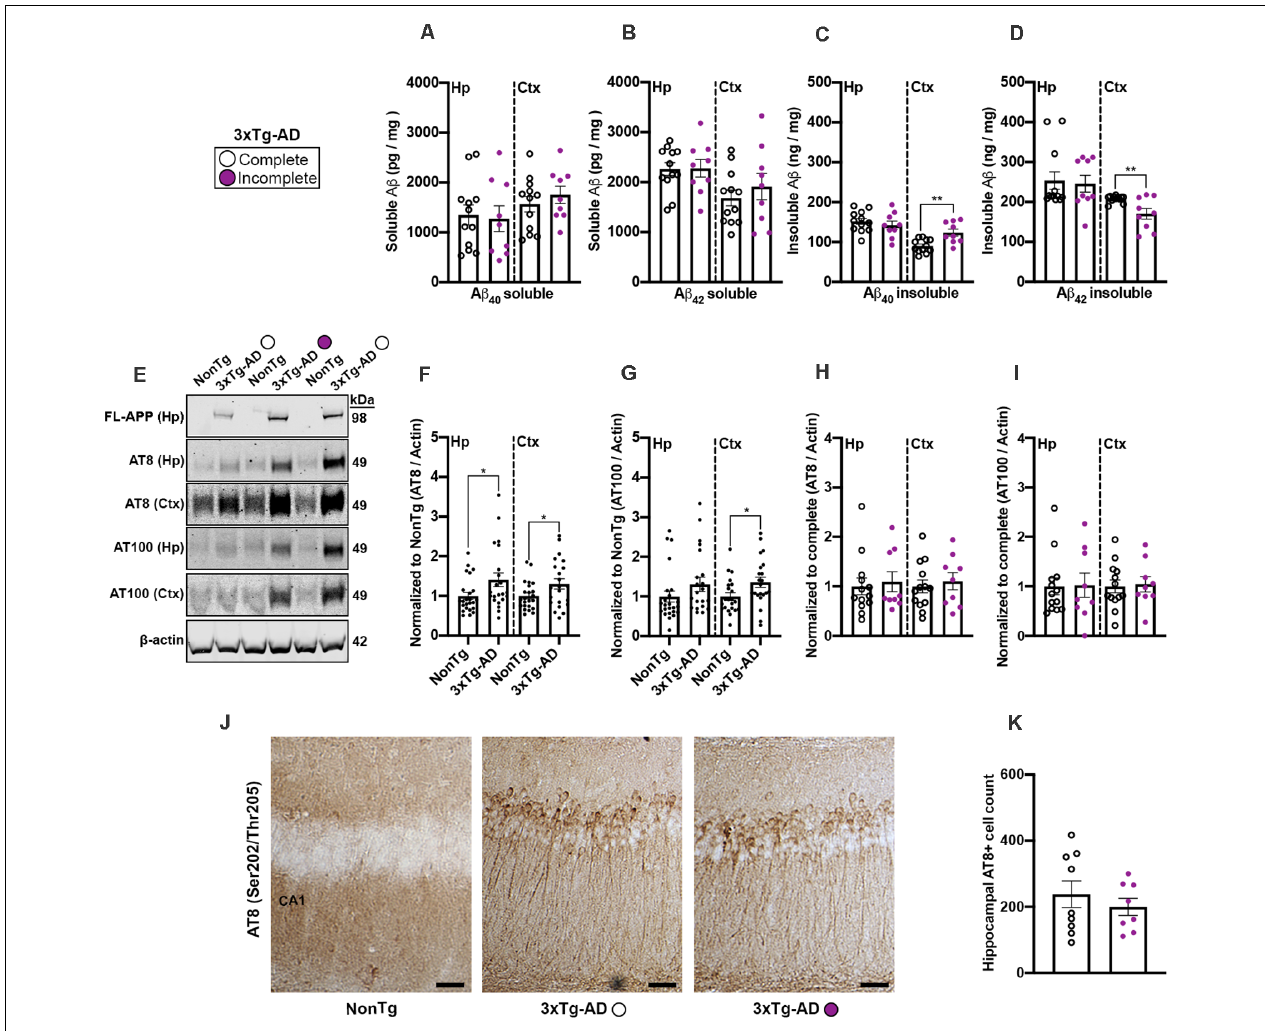
FIGURE 6 | 3xTg-AD mice that were unable to complete the IntelliCage adaptation phases showed increased insoluble Aß 40 levels and decreased insoluble Aß 42 levels. (A,B) No significant differences of soluble Aß 40–42 in the hippocampus (Hp) or cortex (Ctx) were found between 3xTg-AD that completed the IntelliCage tasks compared to 3xTg-AD incomplete mice. (C) We found that 3xTg-AD complete mice had a significantly lower level of insoluble Aß 40 in the cortex than the 3xTg-AD incomplete mice ( p < 0.01). (D) We found that 3xTg-AD complete mice had a significantly higher level of insoluble Aß 42 in the cortex than the 3xTg-AD incomplete mice ( p < 0.01). (E) Representative western blots of human APP, phospho(p) Ser202/Thr205 (AT8), Thr212/Ser214 (AT100), and ß-actin loading control. (F) 3xTg-AD mice showed higher expression of AT8 in the Hp and Ctx than NonTg mice. (G) 3xTg-AD mice show higher expression of AT100 in the Ctx than